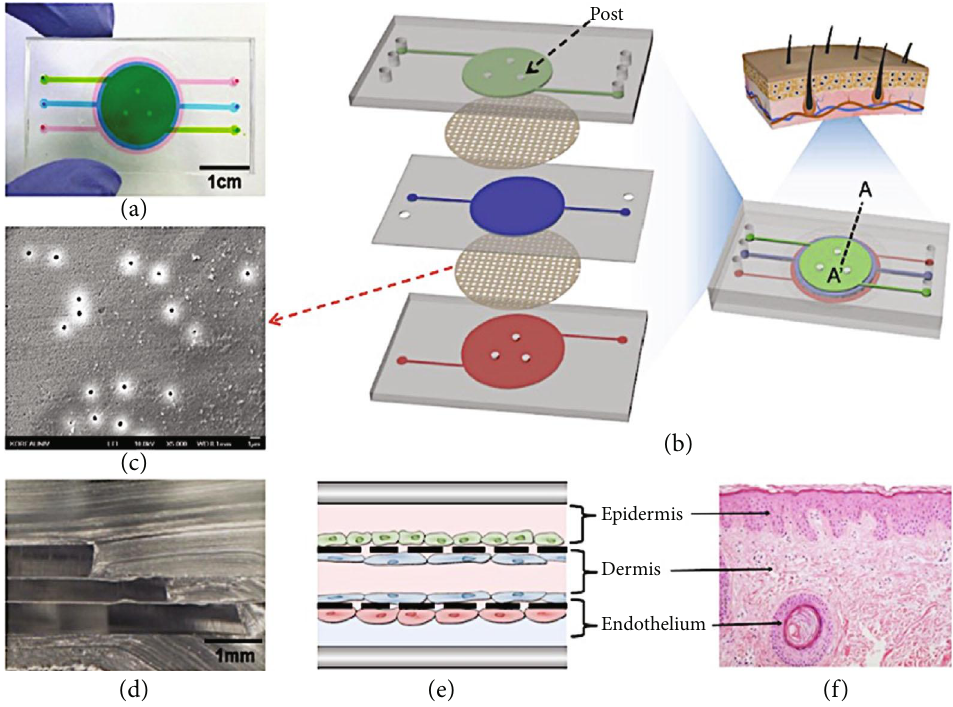
Figure 20: Description of the micro fl uidic device. (a) Image of a skin-on-a-chip device fi lled with fl uid in three di ff erent colors. (b) 3D scheme of the skin-on-a-chip system comprising three PDMS layers and two PET porous membranes (footprint: 48mm × 26mm ; height: 7mm). (c) SEM image of PET porous membranes (pore size: 0.4 μ m) obtained from Transwell. (d) Cross-sectional image of A – A ′ . (e) Schematic of the skin-on-a-chip system, including three separate channels with four vertically stacked cell layers. (f) Representative histological skin section stained with hematoxylin and eosin to indicate the cellular organization of skin. Reproduced (or adapted) with permission [108], ©2016,